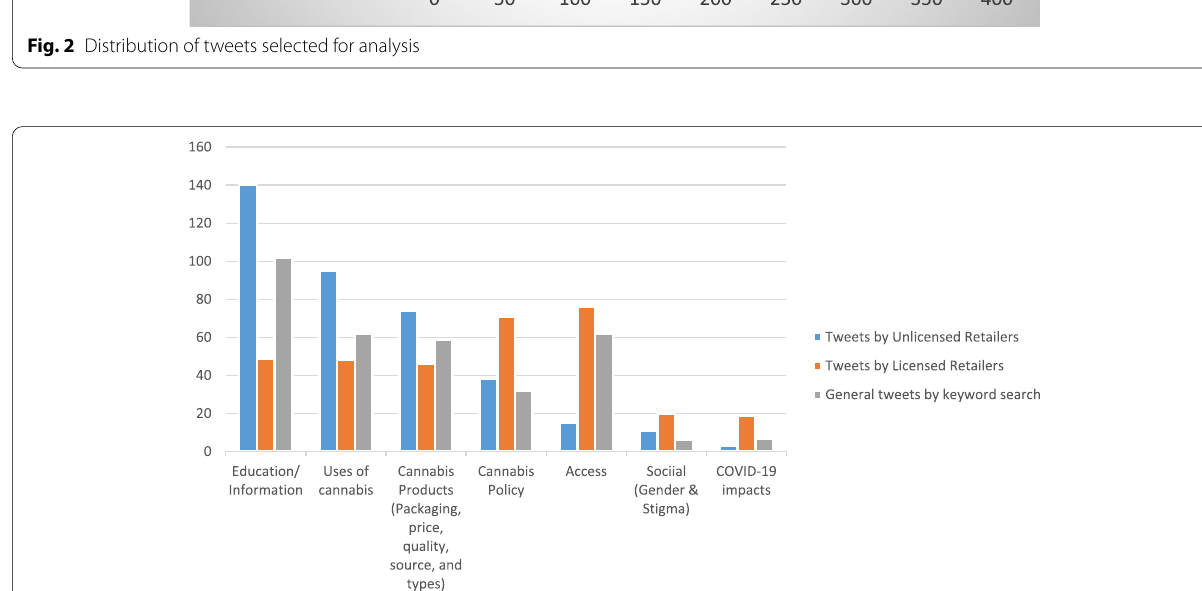
Fig. 3 Thematic representation of the